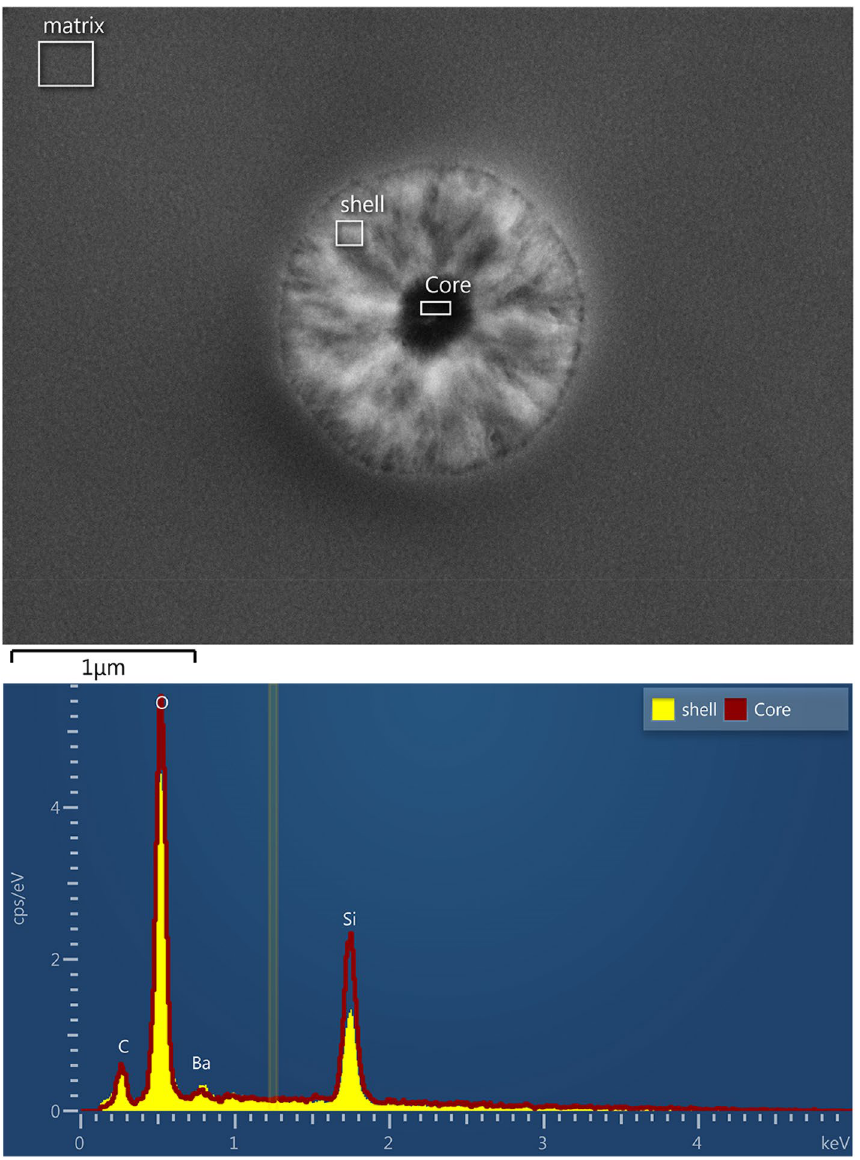
Figure 8. EDS of the core and shell of the fractured and 0.1% HF etched